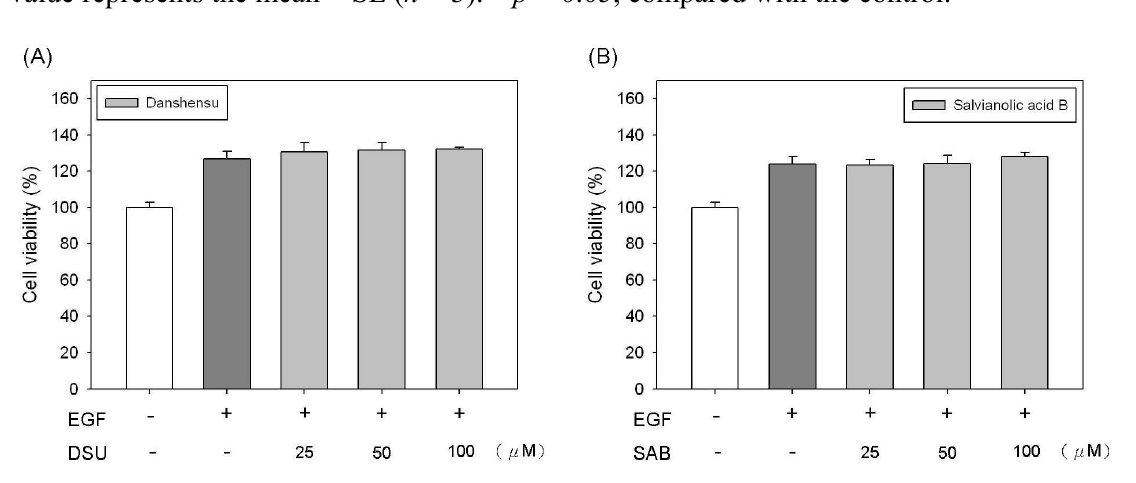
Figure 3. The effects of ( A ) danshensu (DSU) and ( B ) salvianolic acid B (SAB) on the cell proliferation of epidermal growth factor (EGF)-treated Detroit 551 cells in 0.2% FBS. Each value represents the mean ± SE ( n = 3). * p < 0.05, compared with the